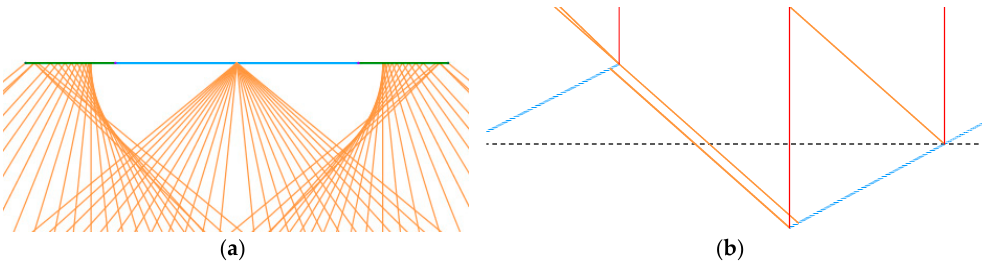
Figure 8. Results of the ray tracing. ( a ) Approach of the receiver. ( b ) Blocking of reflected rays between the last and second last mirror.